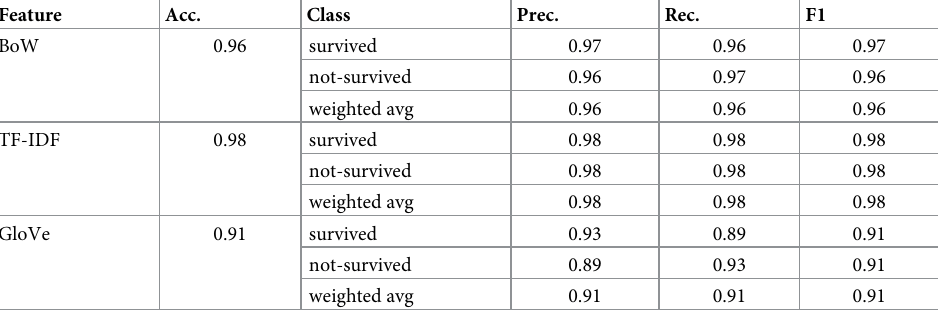
Table 14. Classification results of proposed ER-VC model for binary classification on SMOTE-balanced data. Feature Acc. Prec.